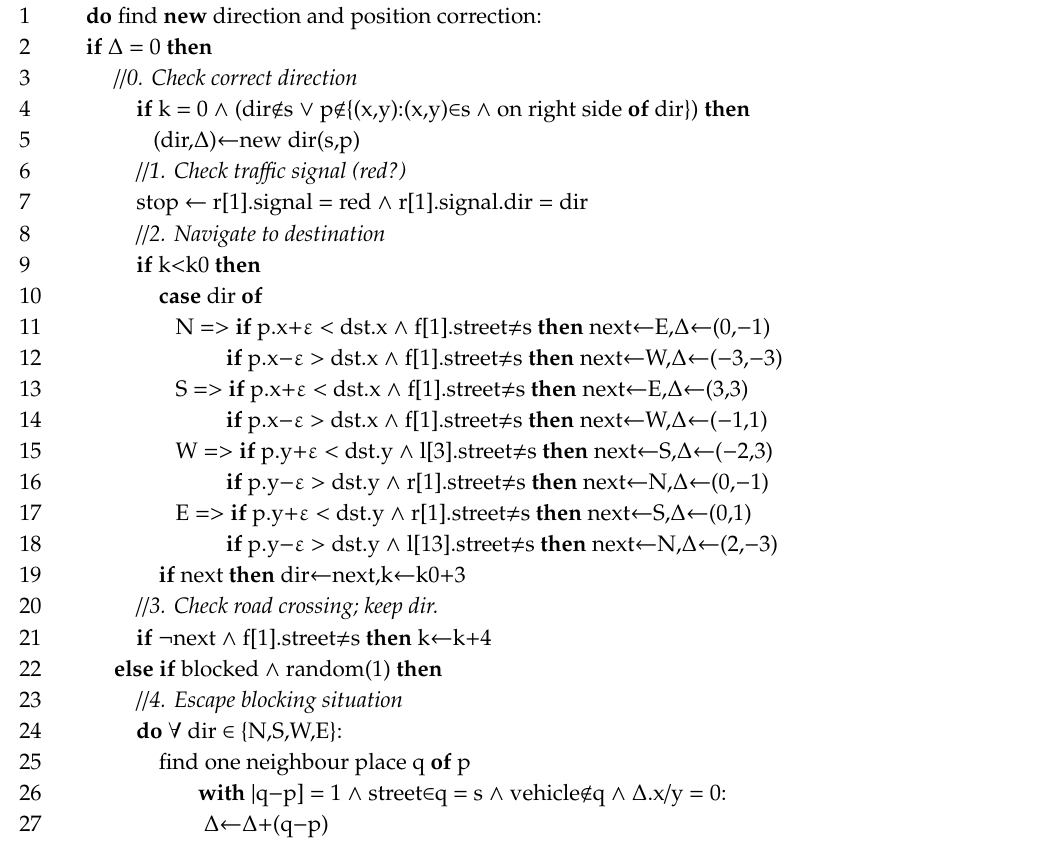
Algorithm 4. Simplified planning activity of the vehicle agent, which can be depend on twin driver and partly on passenger agents,